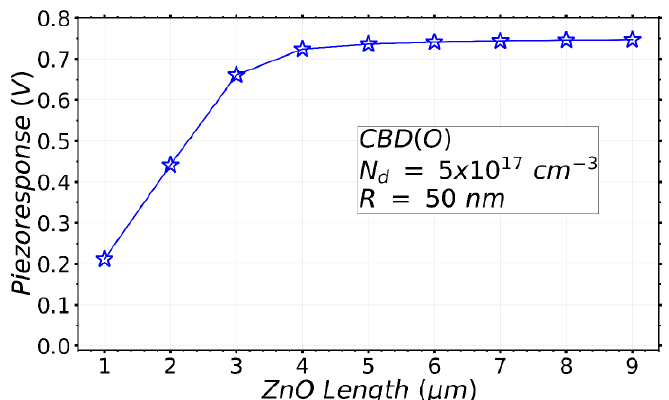
Figure 8. Variation of the piezoresponse of a VING device as a function of the NW length. The parameters of the NW used in the model correspond to ZnO NWs grown by the CBD (O) method.